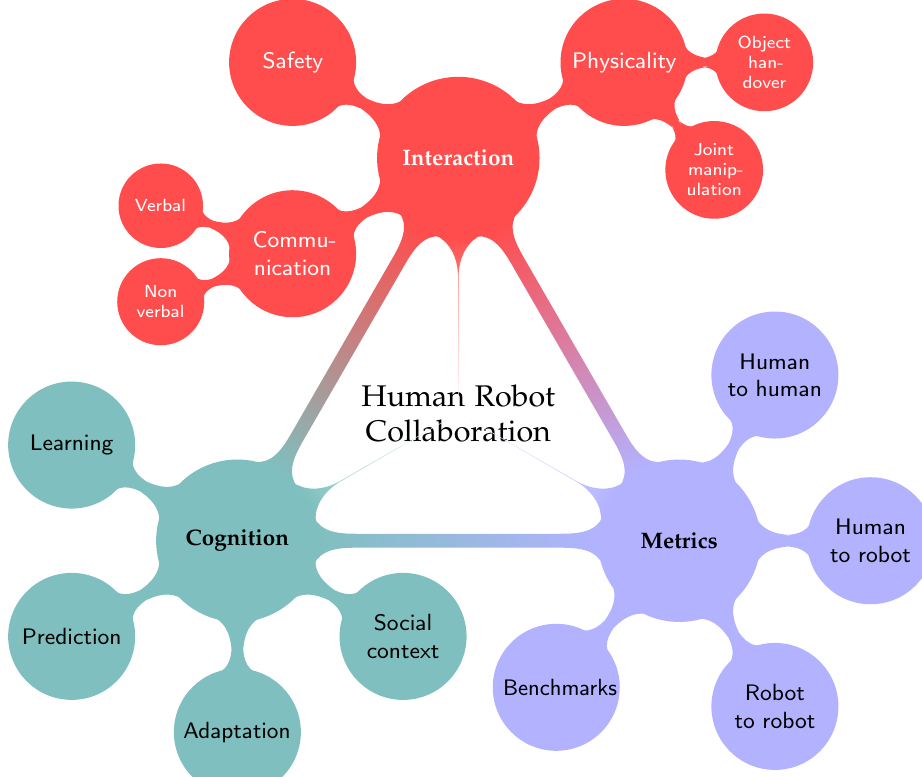
Figure 1. Mind map of the Human-Robot Collaboration